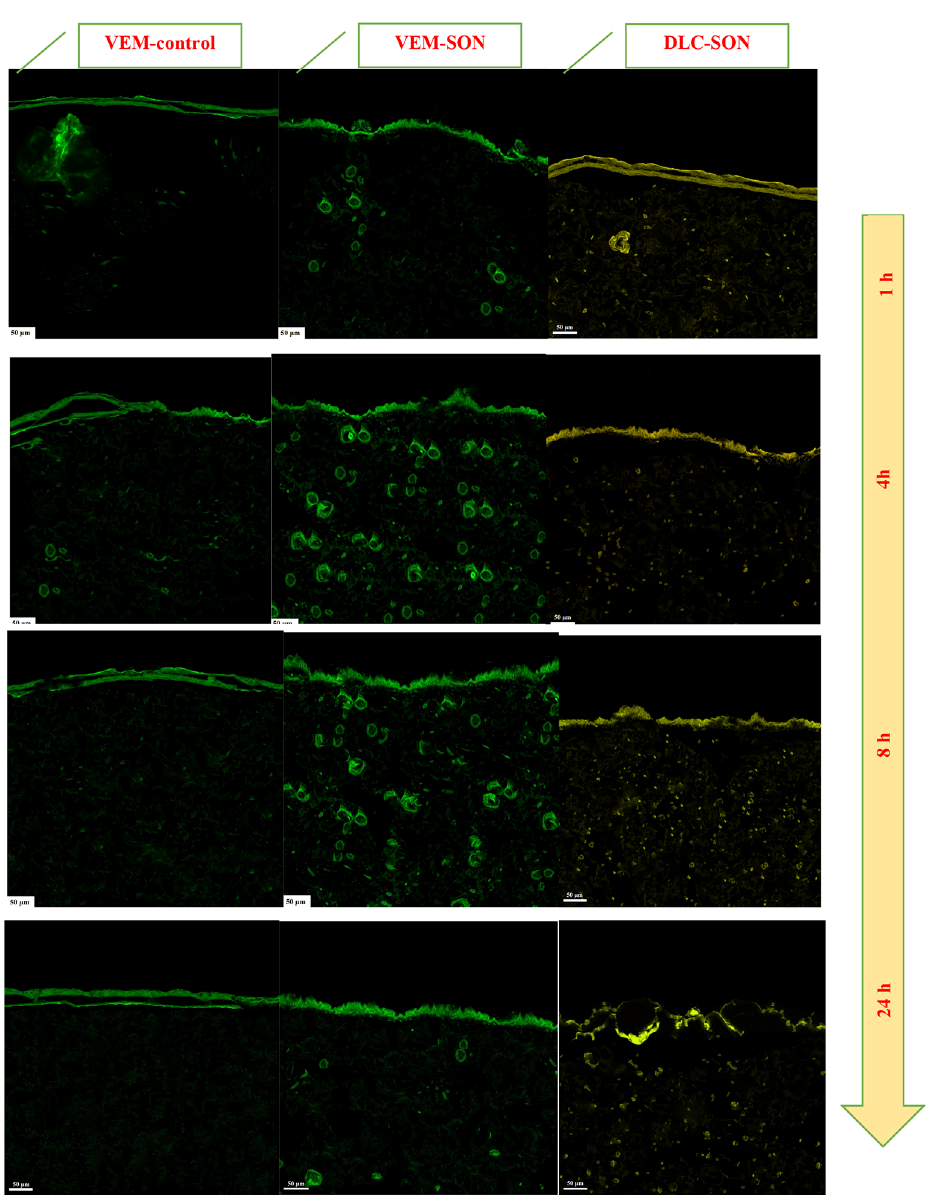
Figure 11. CLSM for the treated rats' skin sections treated with (A) VEM-control, (B) the prepared VEM-SON formula, and (C) DLC-SON, after application of LYCH and FITC (scale bar: 50 μ m). Samples were applied at 1, 4, 8, and 24